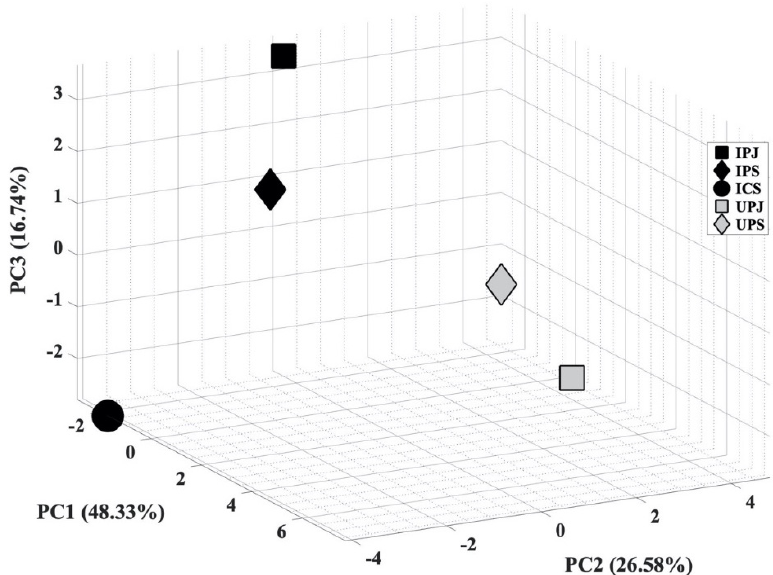
Figure 3. Score plot of principal component analysis (PCA) from GC-MS result.